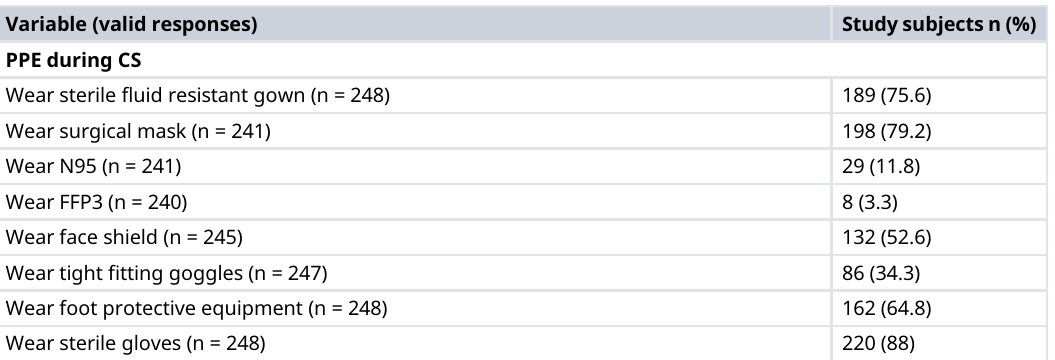
Table 3. Pattern of PPE use & infection control measures among study